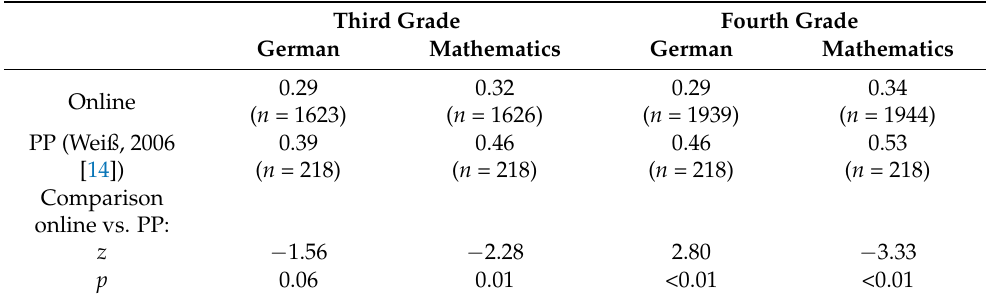
Table 2. Correlations between the CFT 20-R raw scores and school grades in German and